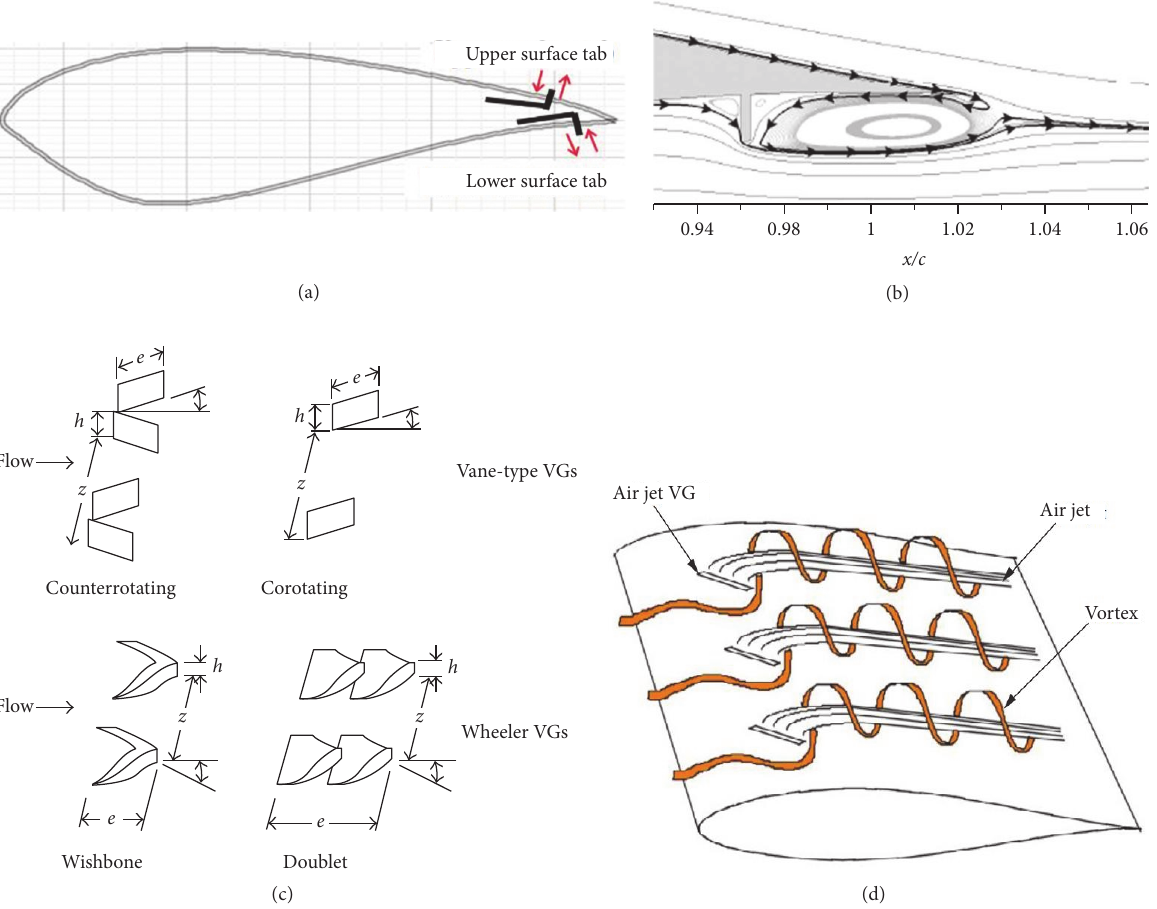
Figure 12: Active flow control devices, (a) Microtab [99], (b) flow pattern after application of Microtab [100], (c) vortex generators [101], and (d) air jet vortex generator